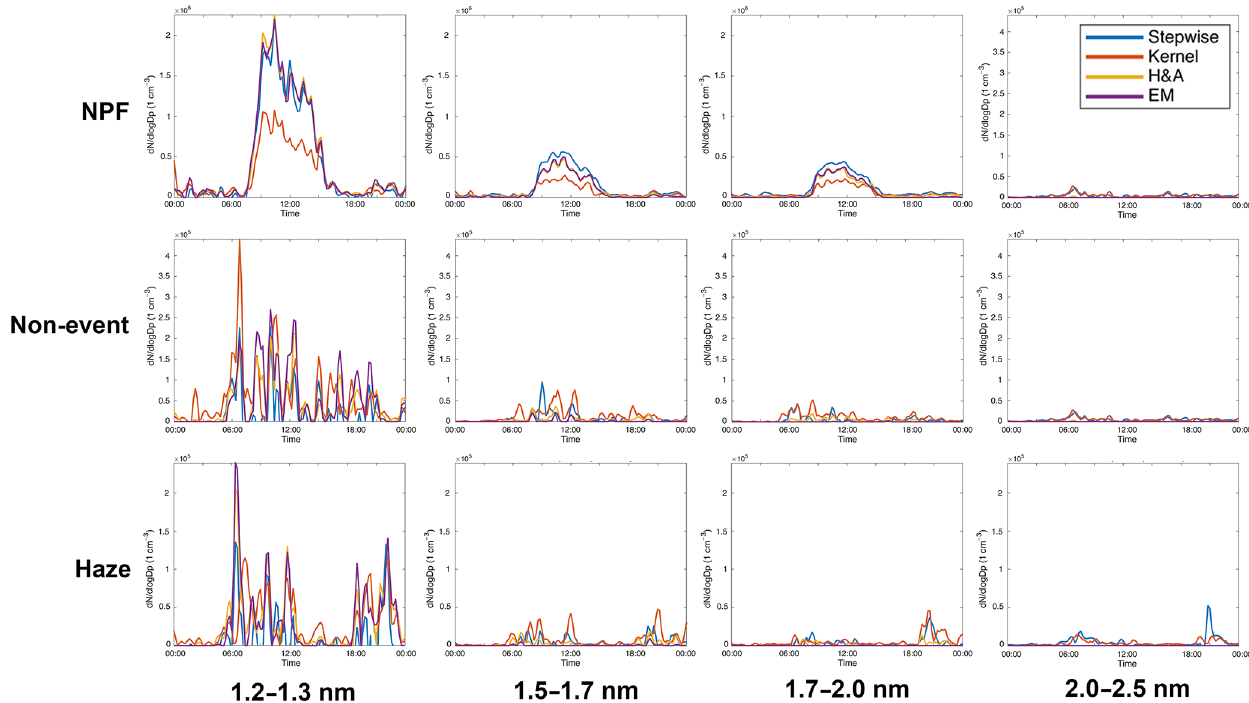
Figure 5. Comparison of size bins from inversions. Event types shown are an NPF event on 30 January 2018 (top row), a non-event on 6 March 2018 (middle row) and a haze event on 9 March 2018 (bottom